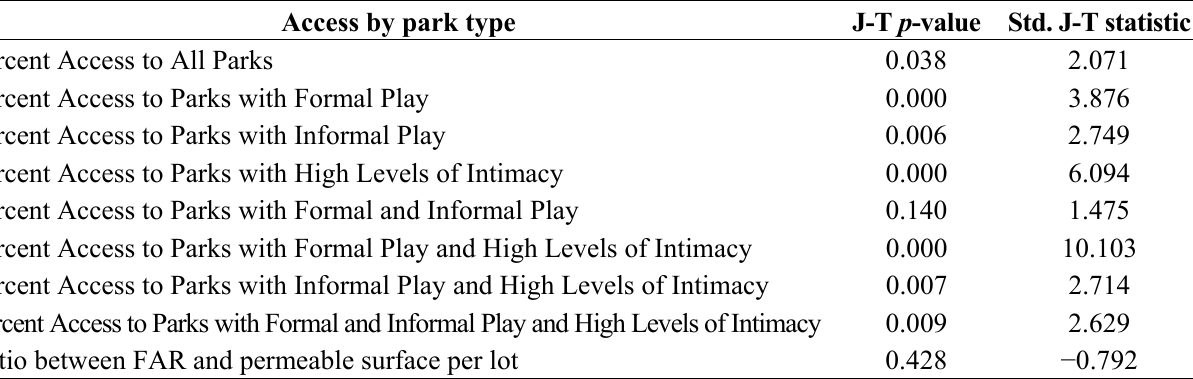
Table 4. Jonckheere-Terpstra (J-T) results and effect size for all access